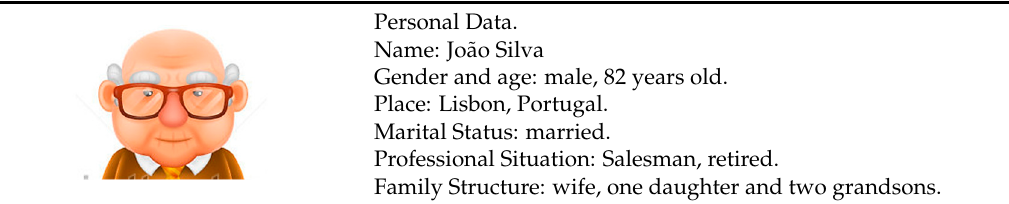
Table 4. Illustrative Scenario.